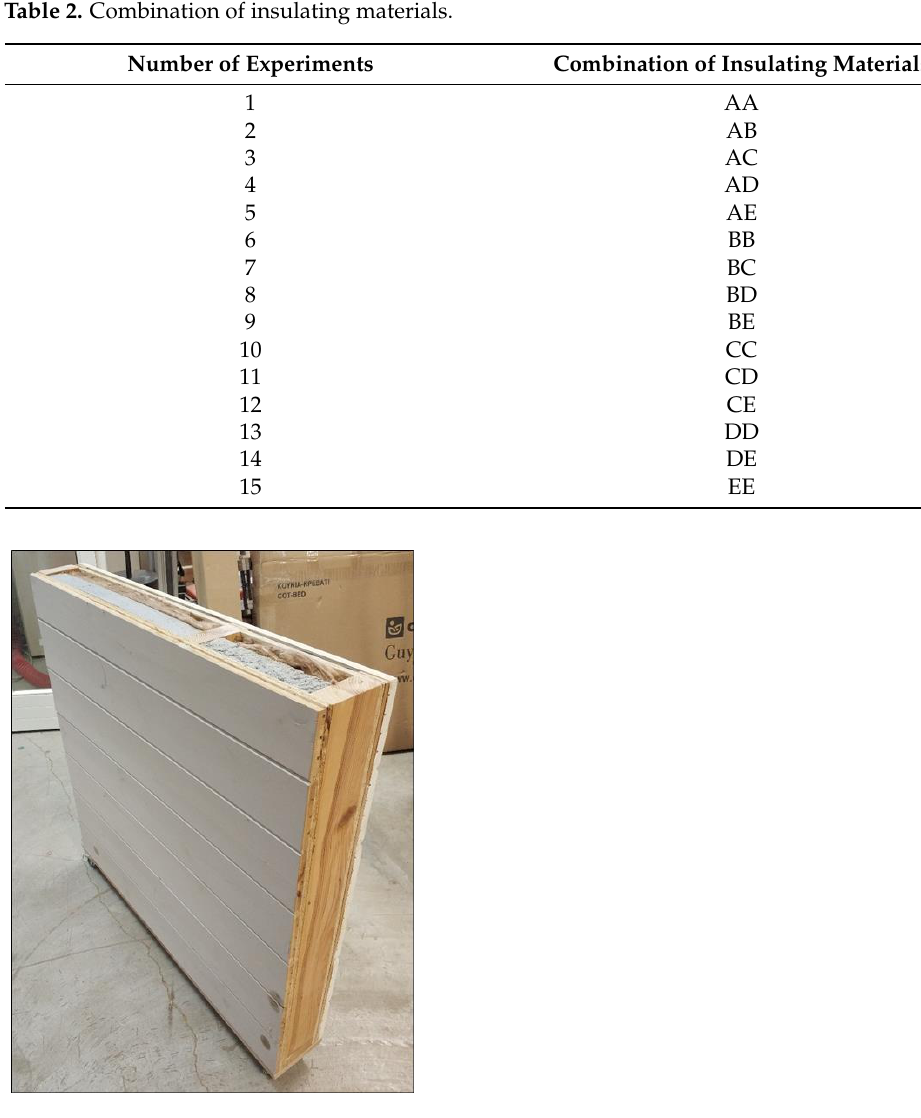
Figure 2. The light-frame timber wall with two dissimilar insulation materials.